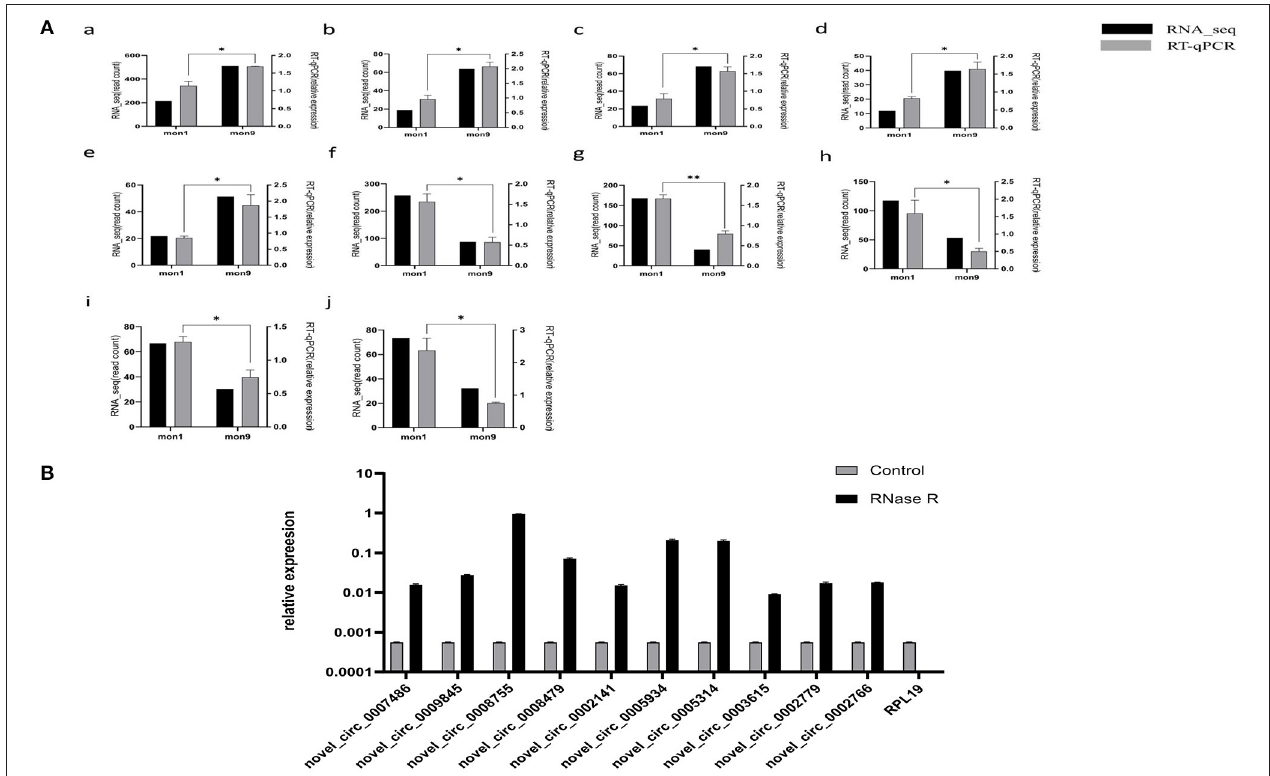
FIGURE 6 | Expression verification of circRNAs. (A) RT–qPCR verification of mon1 and mon9 differentially expressed circRNAs in RNA-seq. Graph numbers of a, b, c, d, e, f, g, h, i and j represent novel_circ_0007486, novel_circ_0009845, novel_circ_0008755, novel_circ_0008479, novel_circ_0002141,